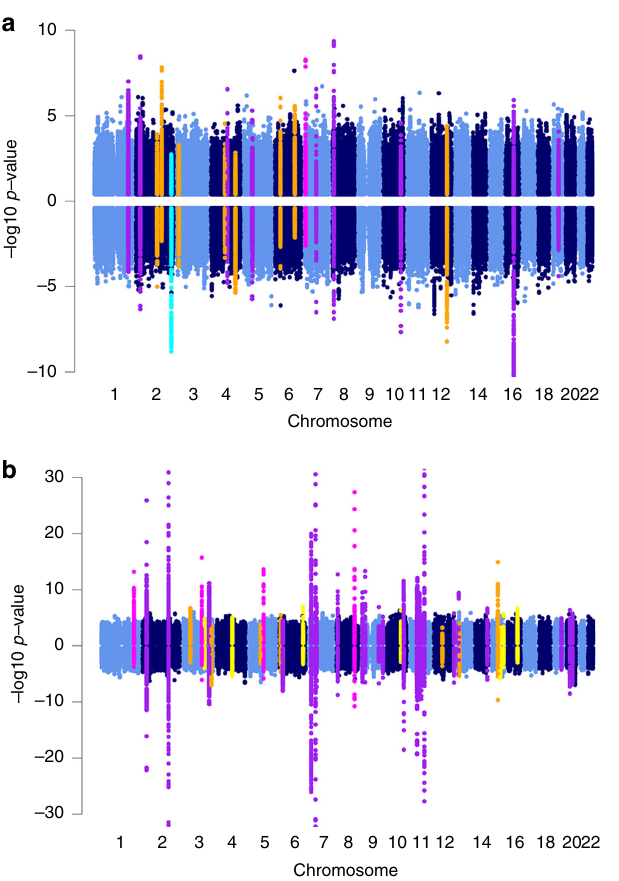
Fig. 1 Miami plots of sex-speci fi c associations. a FI sex-speci fi c associations, b FG sex-speci fi c associations showing women on upper panel (all y axis values are positive) and men on lower panel (all x axis values are negative). Established or novel loci with sex-dimorphic effects ( P sex-dimorphic ≤ 5.0 × 10 − 8 ) and nominal sex heterogeneity ( P heterogeneity <0.05) are shown in magenta (larger effect in women) or cyan (larger effect in men). Novel genome-wide signi fi cant loci from sex-combined analyses with sex- homogeneous effects ( P sex-combined ≤ 5.0×10 − 8 ) are shown in yellow. Established loci reaching genome-wide signi fi cance in sex-combined analyses and showing no sex heterogeneity ( P heterogeneity >0.05) are colored in purple. All remaining established loci (i.e. no signi fi cant sex-dimorphic or sex- homogeneous effects) are marked in